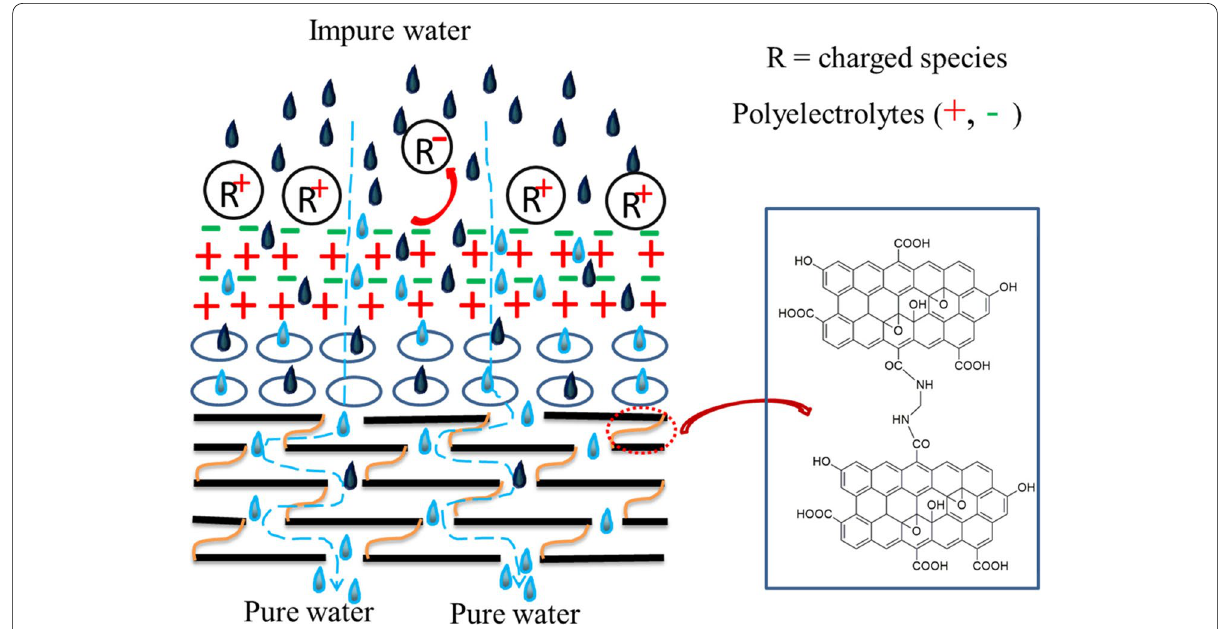
Fig. 13 Mechanism showing performance of PSS-PDA-crosslinked GO